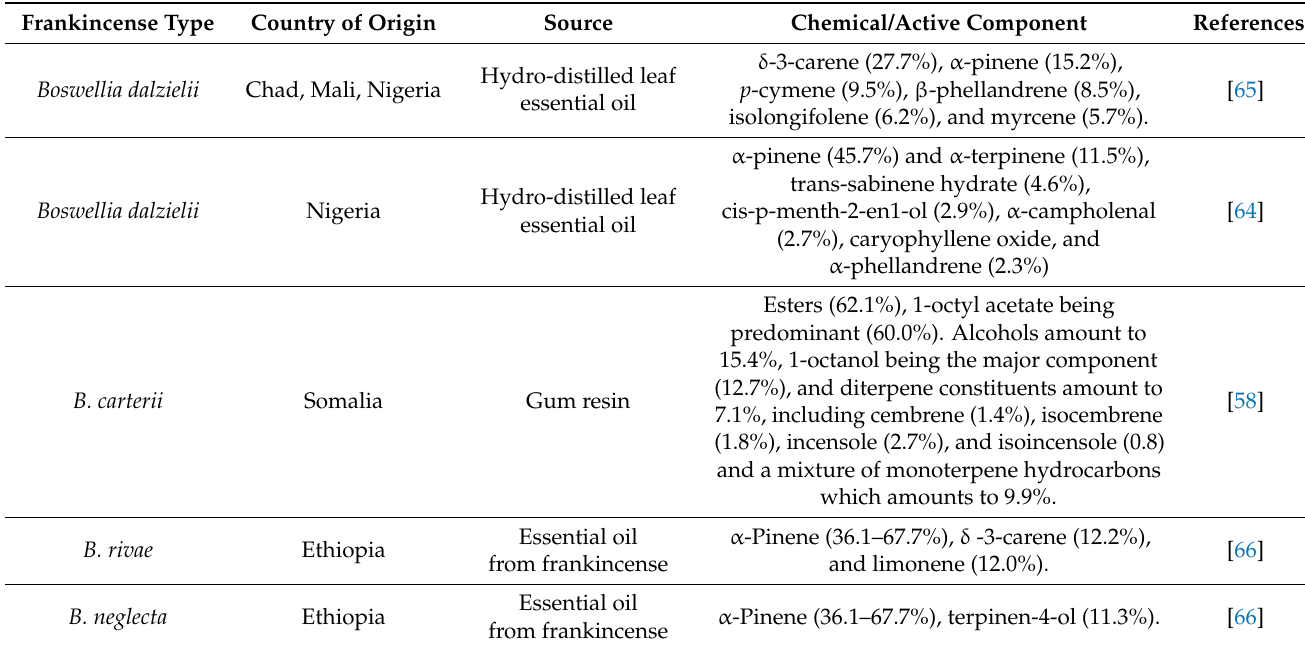
Table 2. Prominent features of compounds in frankincense resin and